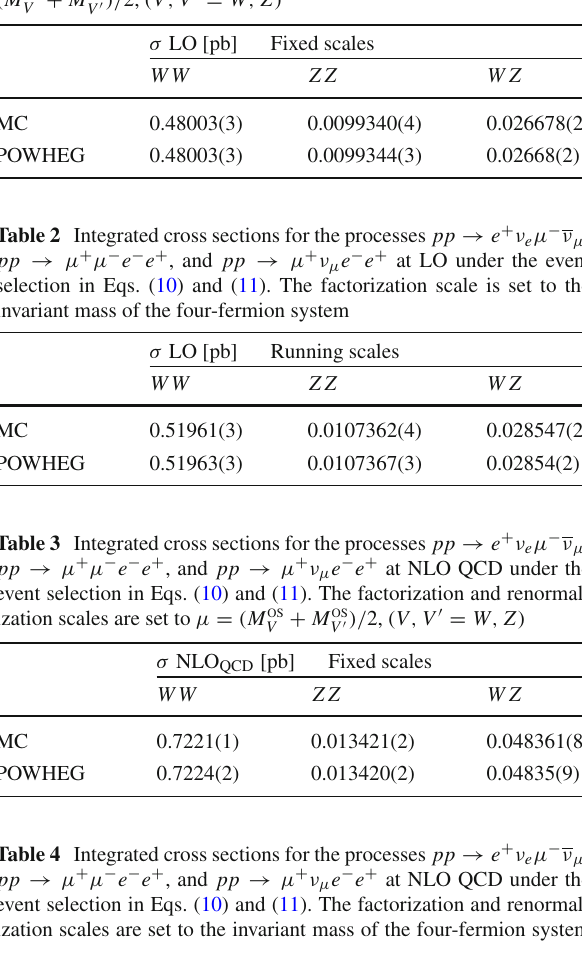
Table 1 Integrated cross sections for the processes pp → e + ν e μ − ν μ ,